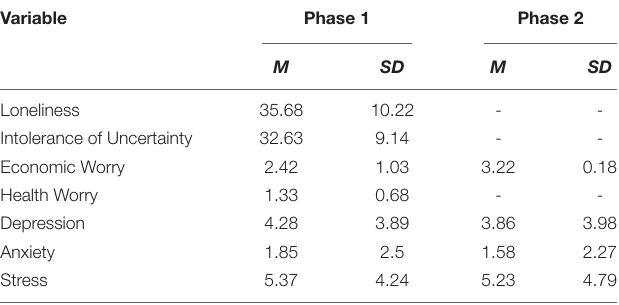
TABLE 3 | Means and SDs for the psychological measures at each phase.